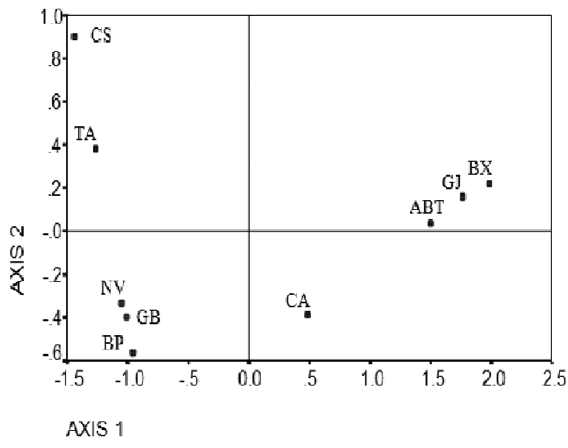
Fig. 3 - Multidimensional Scaling (MDS) comparing Squamata species composition among the nine restinga ecosystems studied on the coast of the State of Bahia, Brazil: CA = Costa Azul; BX= Baixio; GJ= Guarajuba; ABT= Abaeté; GB= Guaibim; BP= Boipeba; CS= Cassange; TA= Taipe; NV= Nova Viçosa.